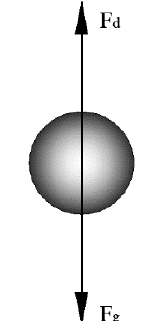
Figure 2. The schematic diagram of the force on a single fine particle.